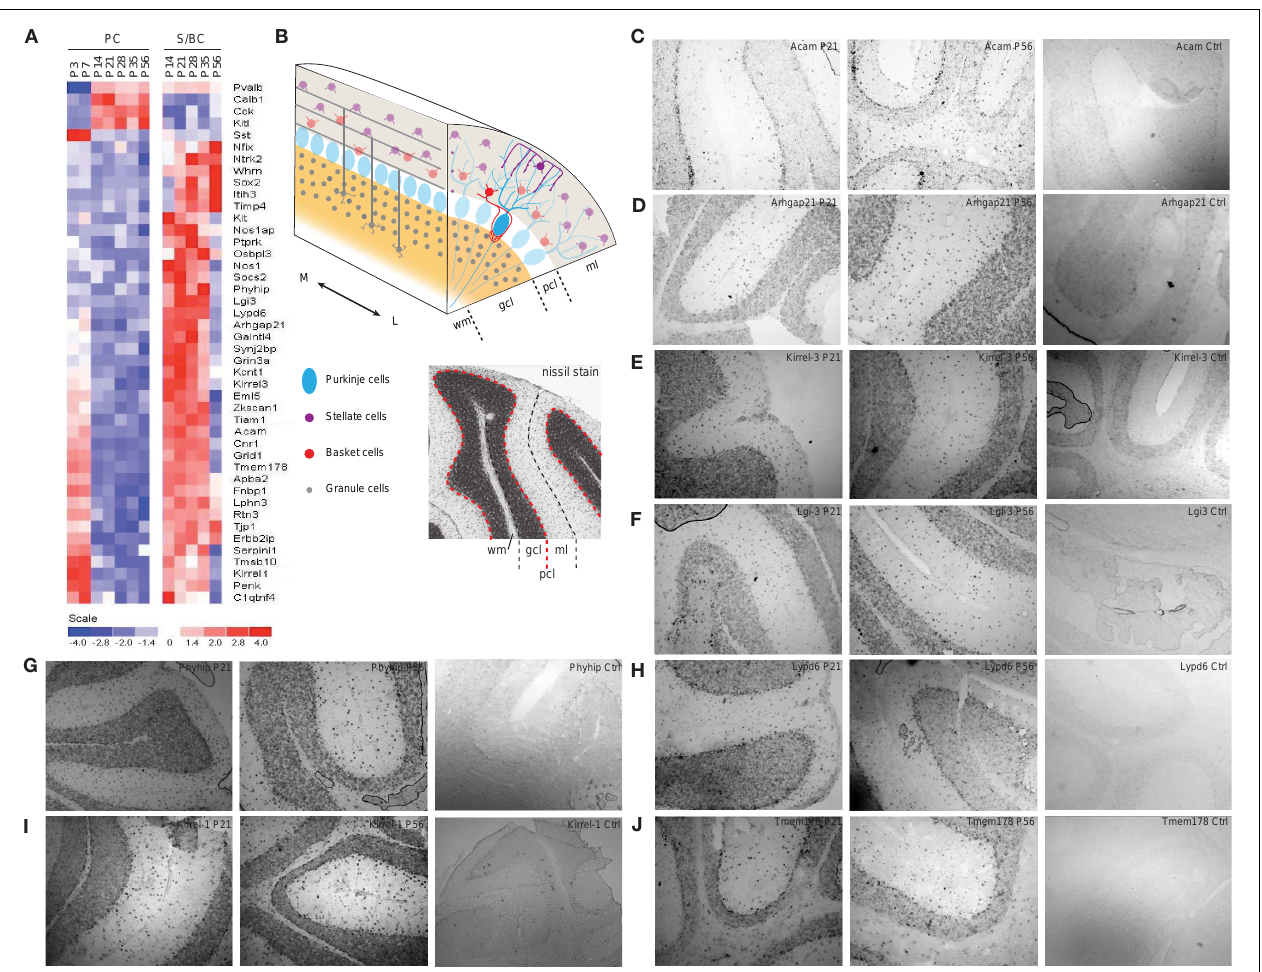
hybridization panels of the novel S/BC transcripts validating the microarray data. Each panel shows two time points P21, P56, and control probes. Abbreviations: gcl, granule cell layer; ml, molecular layer; pcl, Purkinje cell layer; wm, white matter; M, medial; L,